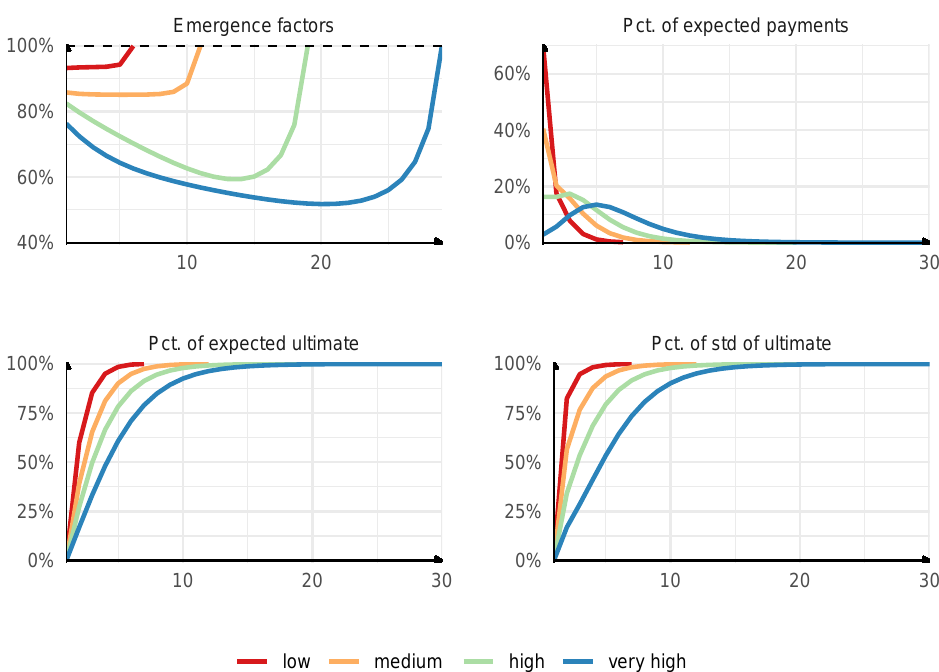
Figure A3. Plausibility tests performed for the simulation study without the estimation error. Additionally, we analyse developments of loss triangles by studying the maximum and the minimum of 99.5% and 0.5% quantiles of the simulated individual claims development factors across accident years and development periods (see Table A1). For the